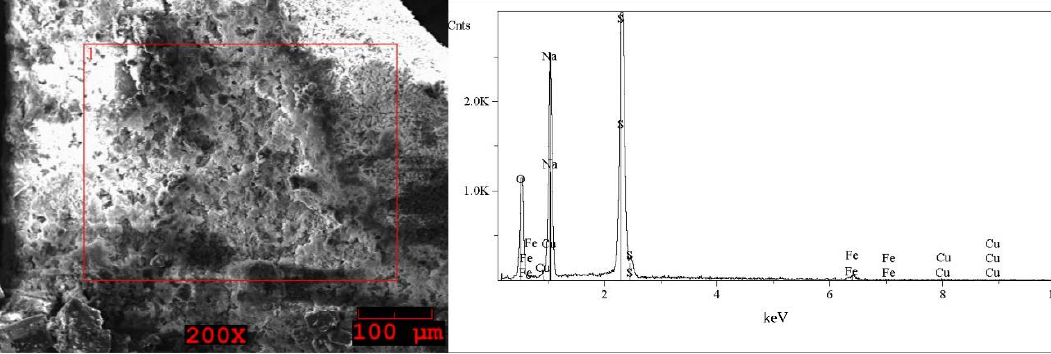
Figure 9. SEM image of the white solid phase sample precipitated out from the post-leaching solution II (second step) and EDS spectrum taken from the area marked in the image.